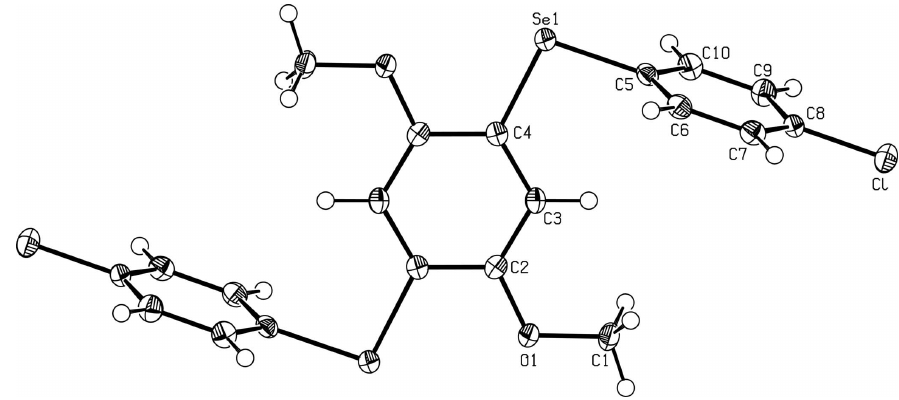
Figure 1 Thermal elipsoid plot of (1) including labelling of the atoms. The displacement ellipsoids are drawn at the 50% probability level. H atoms are shown as spheres with an arbitrary radii.